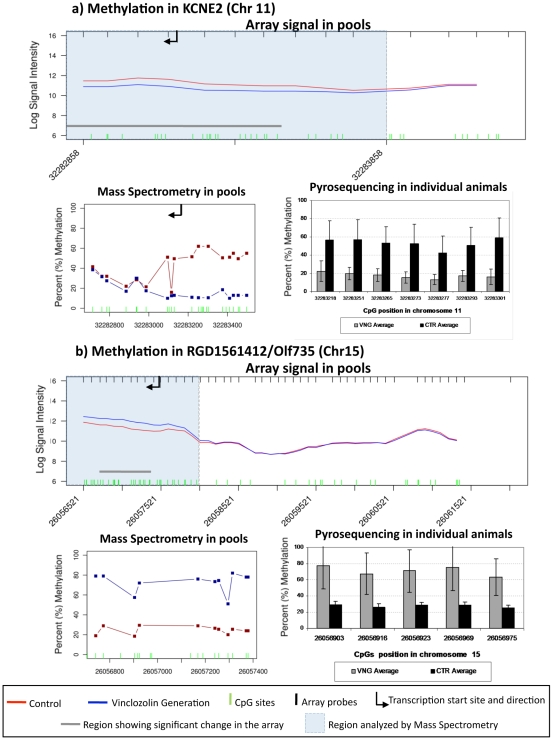
Comparison of the transgenerational methylation change observed between vinclozolin and control in (a) KCNE2 and (b) RGD1561412/Olr735.Analysis of methylation through MeDIP followed by comparative hybridization is graph on top with genome location and log signal intensity presented with shaded area being the differential methylation region. Heavy red line indicates control and blue line indicates vinclozolin and arrow indicates transcriptional start site and direction. The graph on bottom left is the bisulfite mass spectrometry analysis of CpG sites within bar in shaded area of the top graph indicated with percent methylation data presented. Horizontal axis shows chromosomal localizations. In addition, comparison between methylation for these genes in individual animal samples of DNA is shown using pyrosequencing, bottom right graph with percent methylation presented for individual animals (n = 6) mean± SEM for specific CpG in the differential methylation region. Horizontal axis shows chromosomal localizations.